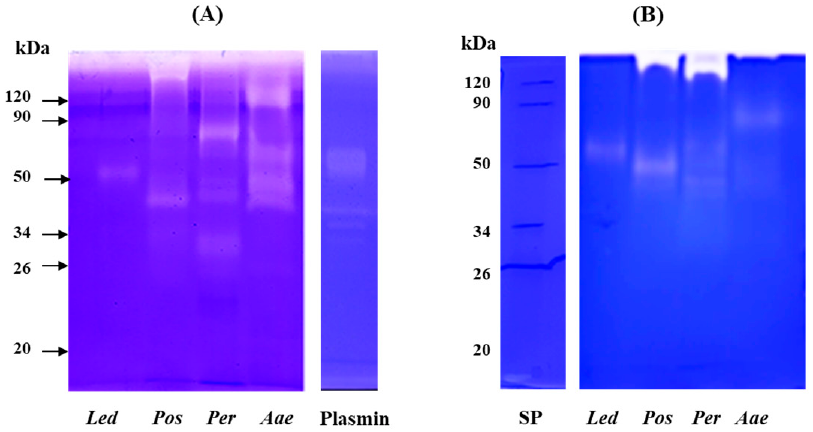
Figure 5. Analysis of fibrinolytic and fibrinogenolytic activity by zymography. Zymograms were carried out under non-reducing conditions on 10% ( w / v ) polyacrylamide gels copolymerized with 0.2% ( w / v ) human fibrin ( A ) or 0.14% human fibrinogen ( B ). Plasmin (2 µg) was used as positive control. Led: Lentinula edodes , Pos: Pleurotus ostreatus , Per: Pleurotus eryngii and Aae: Agrocybe aegerita .